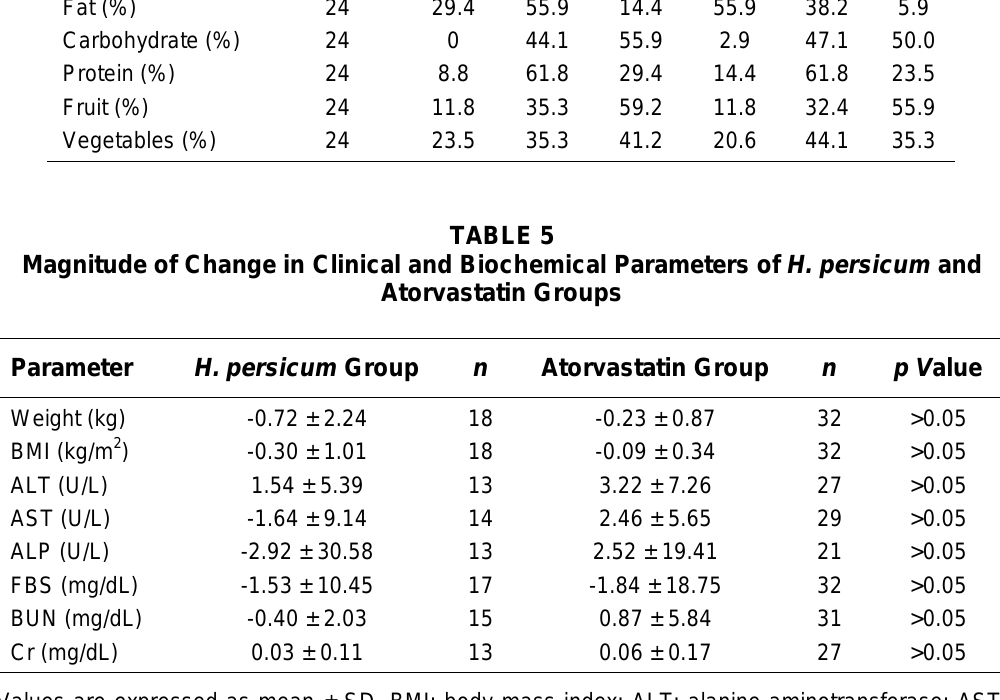
Weekly Diet of the Atorvastatin Group at Baseline and During the Trial Frequency of